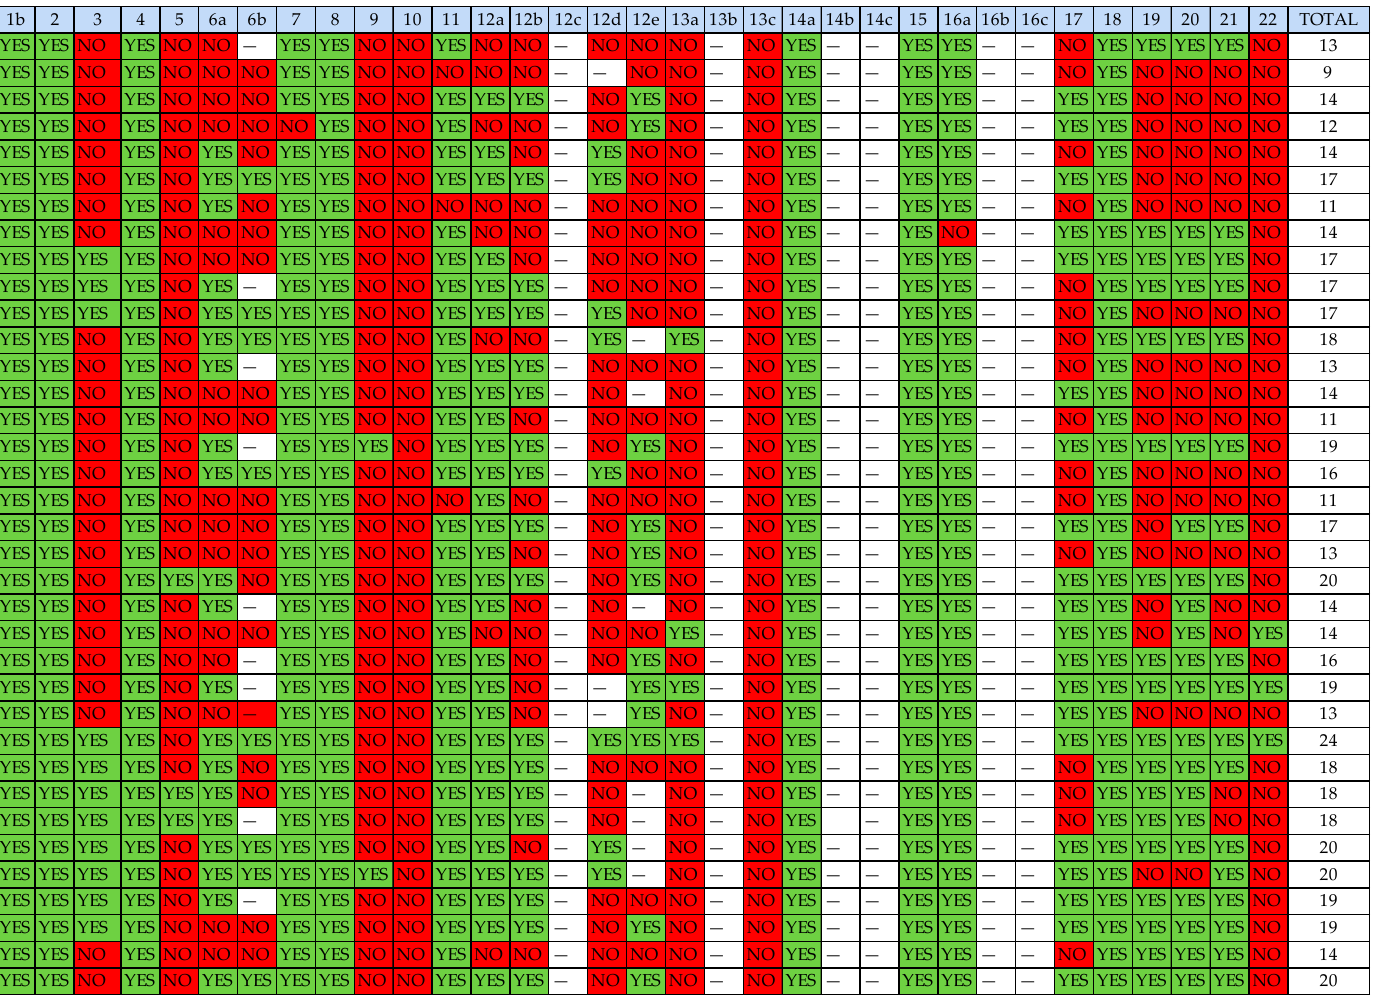
Table 5. Strengthening the Reporting of OBservational Studies in Epidemiology (STROBE) scores of included studies.